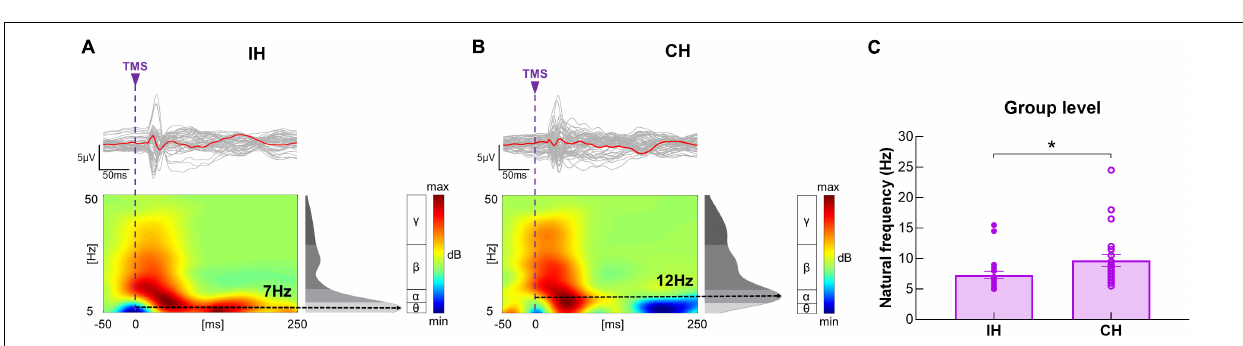
FIGURE 3 | TMS-evoked oscillatory response (EOR) changes after iTBS. Data presented are group mean ± standard error. The top panel presents the data in the IH, and the bottom panel presents the data in the CH. (A–D) presents EOR before and after iTBS in the delta, theta, alpha and beta bands, respectively. The red circles represent the Active iTBS group, and the blue circles represent the Sham iTBS group. There was no significant change in EOR after iTBS in any frequency band in either group.